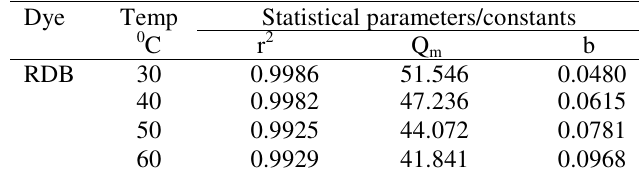
Table 4 . Dimensionless Separation factor (R